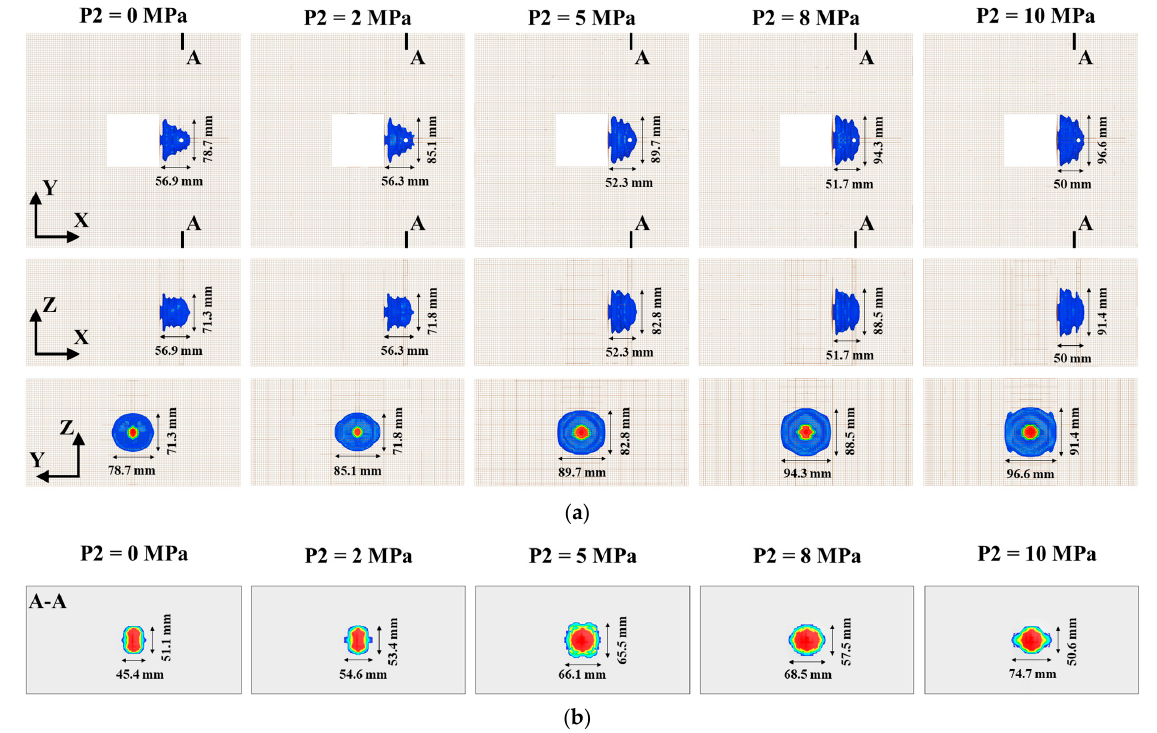
Figure 10. The craters for W = 4 cm under different P2: ( a ) perspective view of craters at different planes; ( b ) section A-A.